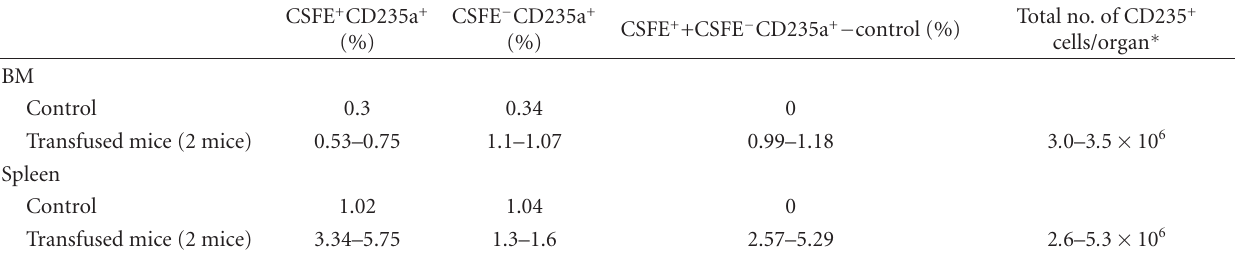
The frequency of human CD235a + cells was obtained after subtracting the background signal observed in untreated controls. ∗ The total number of cells per organ was calculated assuming that a mouse contain 300 × 10 6 BM and 100 × 10 6 spleen cells [19]. at day 21 for the presence of human hematopoietic cells of all lineages (CD45 pos